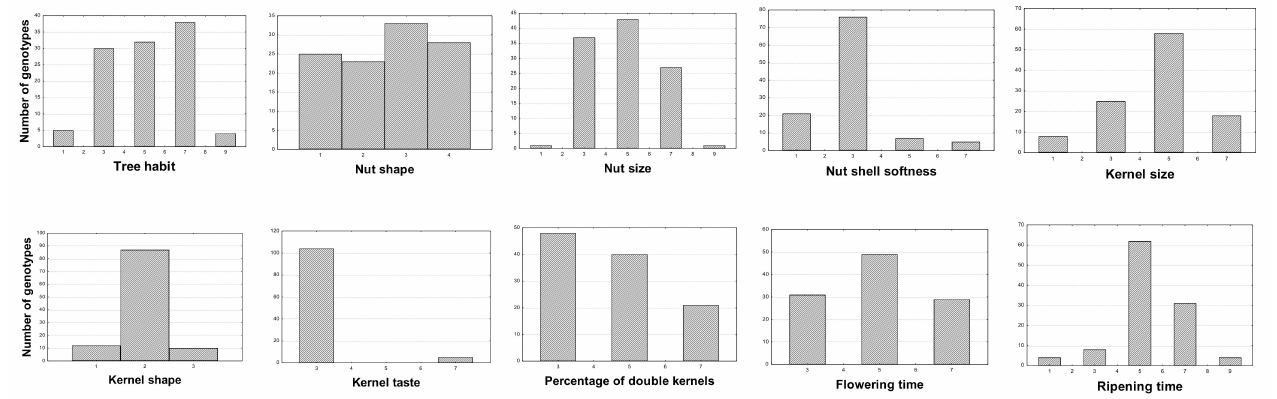
Figure 4. Distribution of the 109 almond genotypes for morphological and phenological traits scored according to GIBA code.